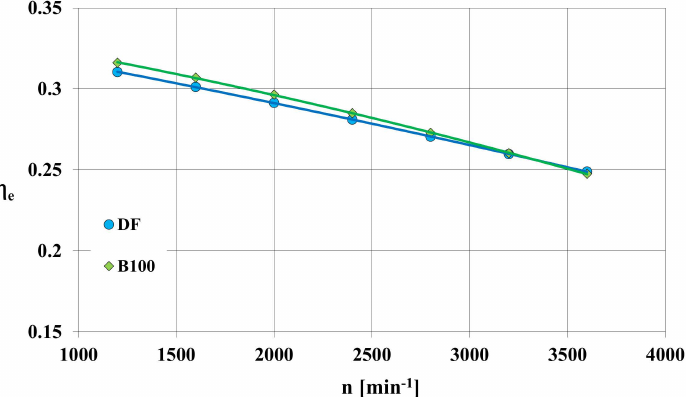
Figure 3. External speed characteristics of the overall efficiency- η e in the rotation speed domain-n for an engine fuelled with DF diesel or B100 fuel.